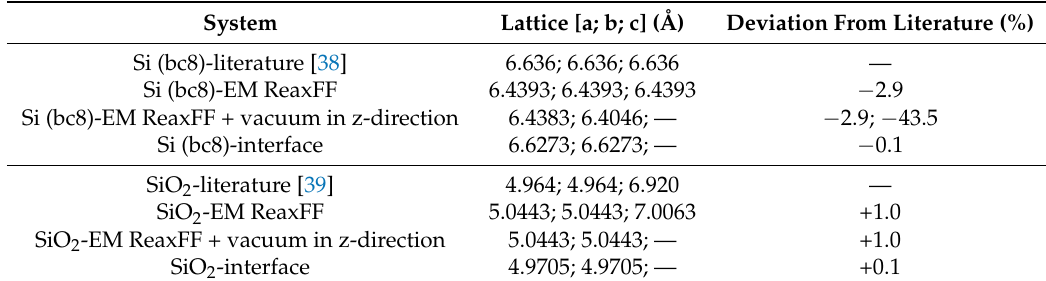
Table A4. Lattice constant for Si (bc8), and cristobalite SiO 2 .